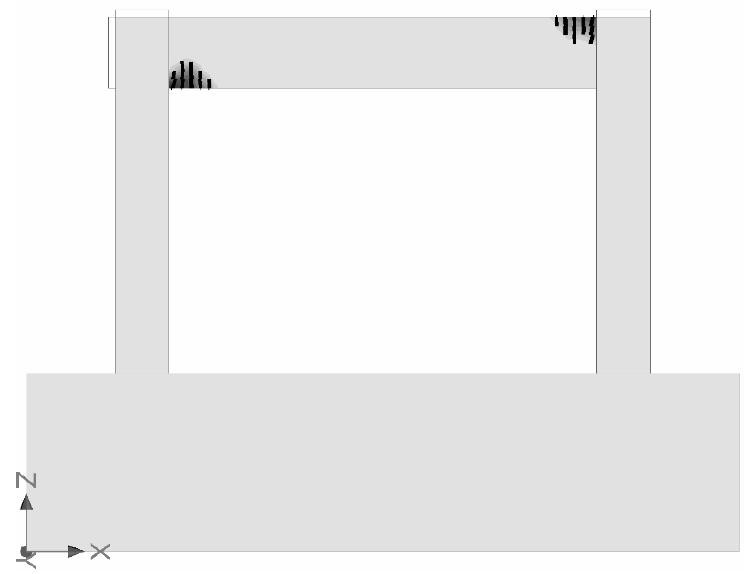
Figure 8. The first crack that occurs in the meso-model.